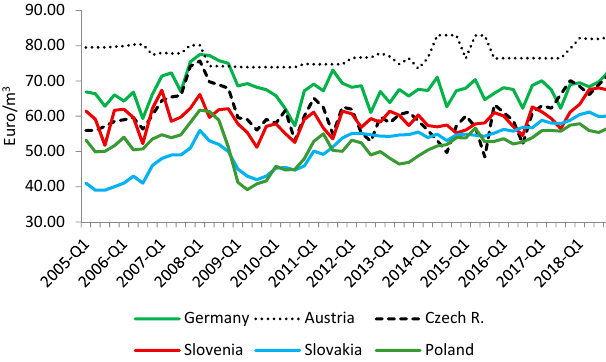
Figure 4. Nominal prices of beech roundwood in selected European countries in 2005–2018. Table 1. Descriptive statistics for quarterly time series of beech roundwood prices in selected European markets.